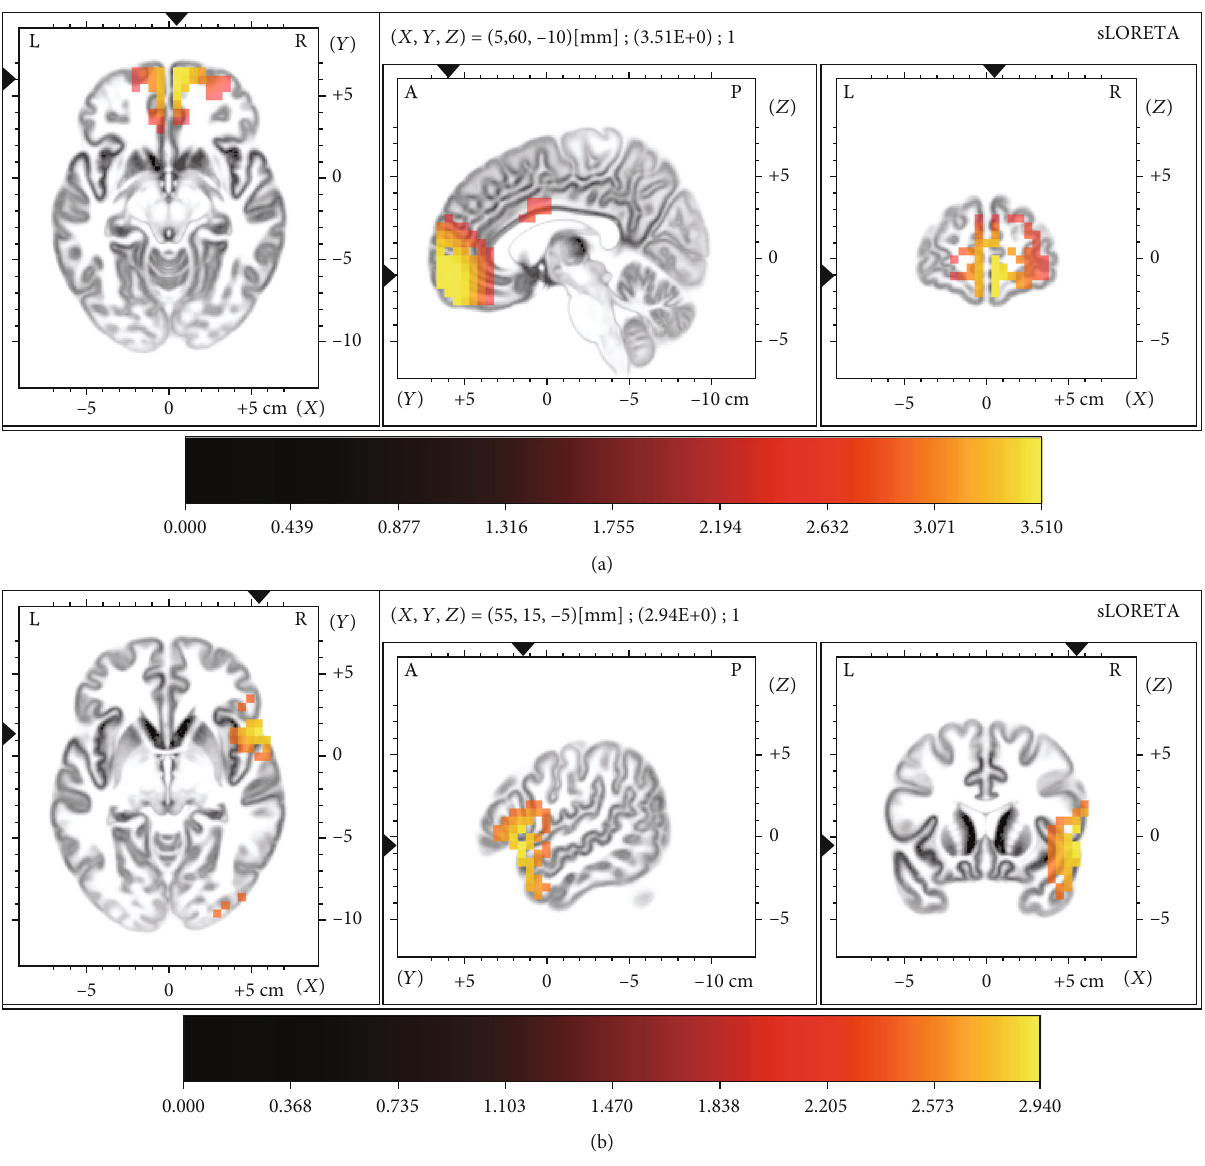
Figure 3: The T -value statistical map corresponding to the P2 and N2. (a) The stronger activity for P2 in HCs; (b) the stronger activity for N2 in HCs. The distinct colors presented the activity of the related brain regions in each sub fi gure. Table 2: The details of the stronger activity for P2 in